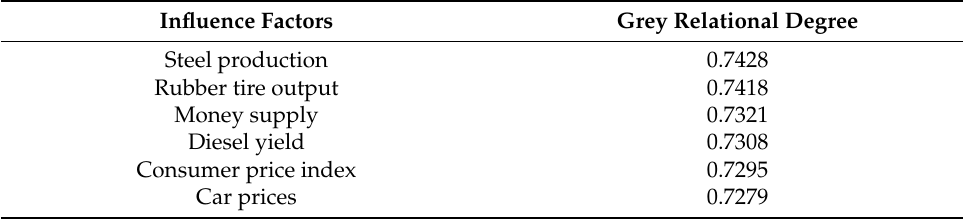
Table 1. Grey correlation between sales and influence factors of Suteng.